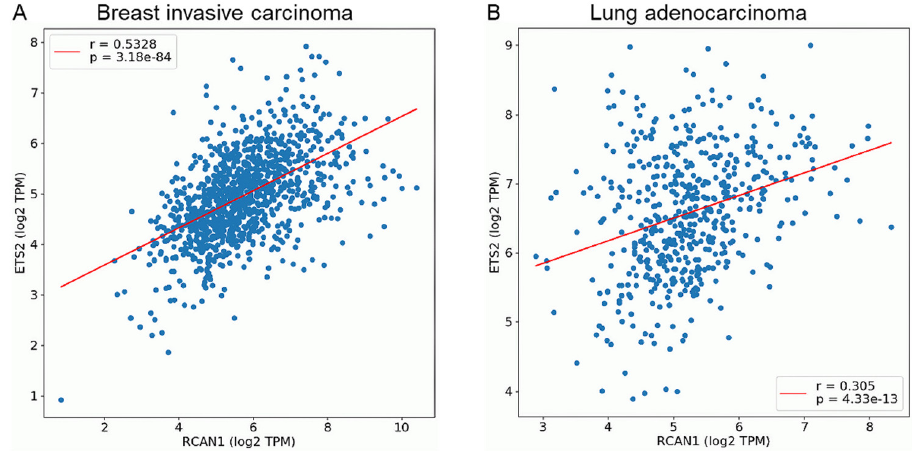
Figure 6. ETS2 and RCAN1 expression are positively correlated in breast and lung cancers. Scatter plots shows the correlation of gene expression of ETS2 and RCAN1 in ( A ) breast and ( B ) lung cancers. Blue dots represent individual mRNA levels expressed as log2 transcript count per million. r: correlation coefficient, p value ≤